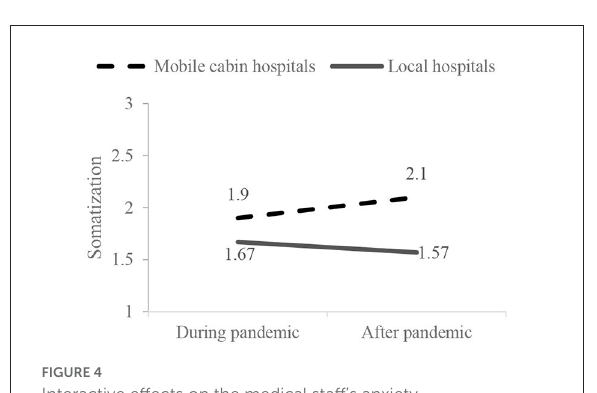
FIGURE4 Interactive effects on the medical staff’s